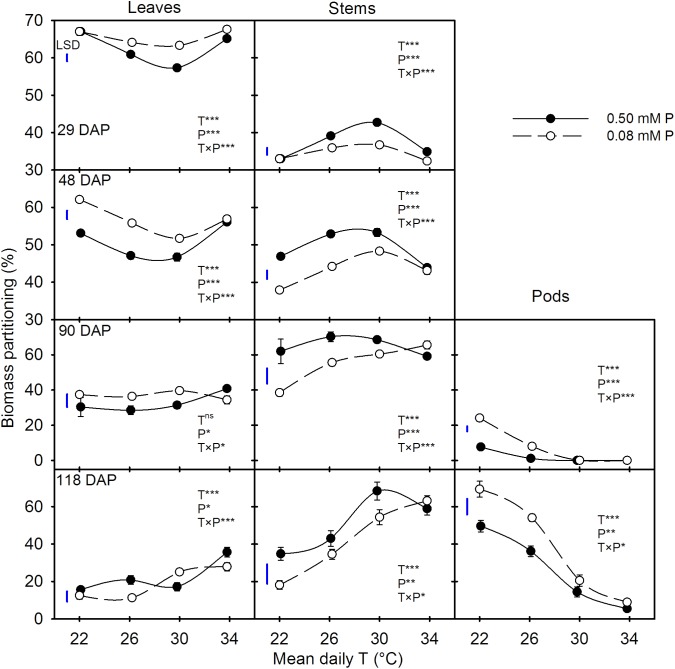
Temperature (T) response of the biomass partitioning to leaves, stems, and pods (%) during destructive harvests made at four different days after planting (DAP) of soybean grown under phosphorus (P) sufficient (0.50 mM P, filled symbols) and P-deficient (0.08 mM P, unfilled symbols) conditions. Symbols represent the mean ± se of 15, 12, 6, and 9 plants at 29, 48, 90, and 118 DAP, respectively. Smooth lines through the data points are presented. The analysis of variance for the effect of treatments and their interaction (T, P, T × P) is also shown by the significance levels, where ∗, ∗∗, ∗∗∗, and ns represent P ≤ 0.05, P ≤ 0.01, P ≤ 0.001, and P > 0.05 (non-significant), respectively. The magnitude of the least significant difference (LSD) is shown by the length of the vertical line. Error bars smaller than the symbol are not visible.